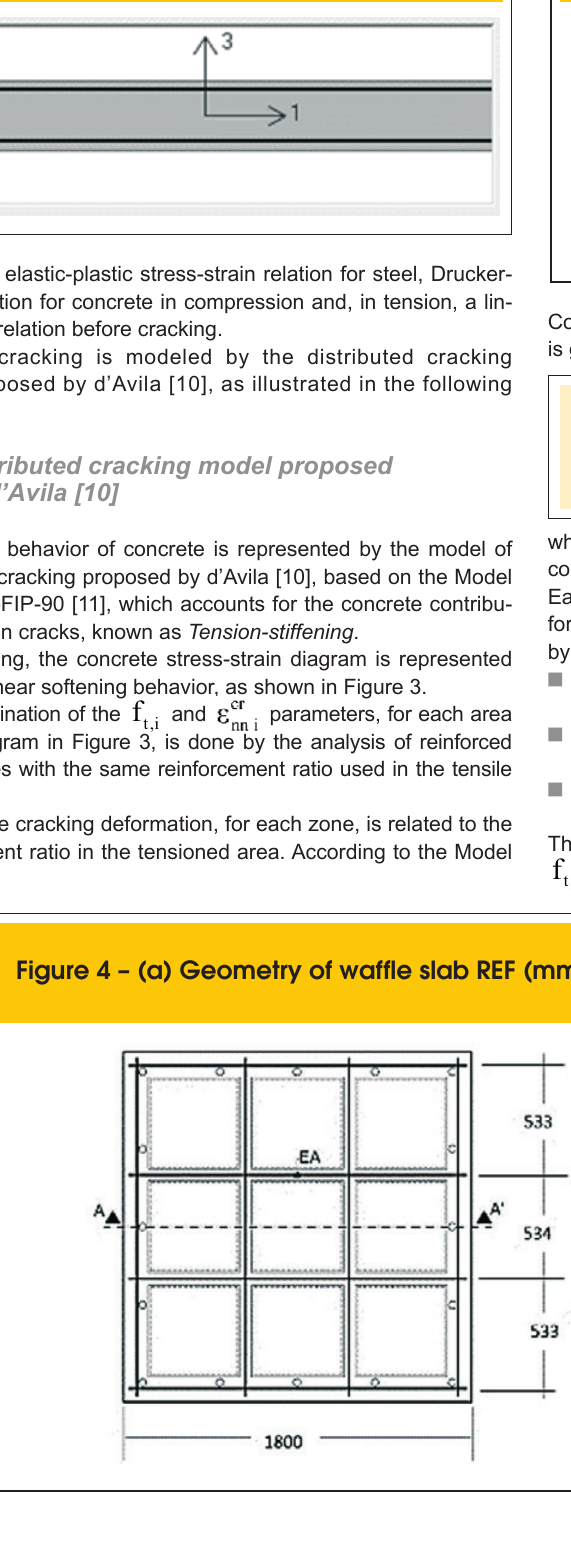
Figure 3 – Distributed cracking model proposed by d'Avila